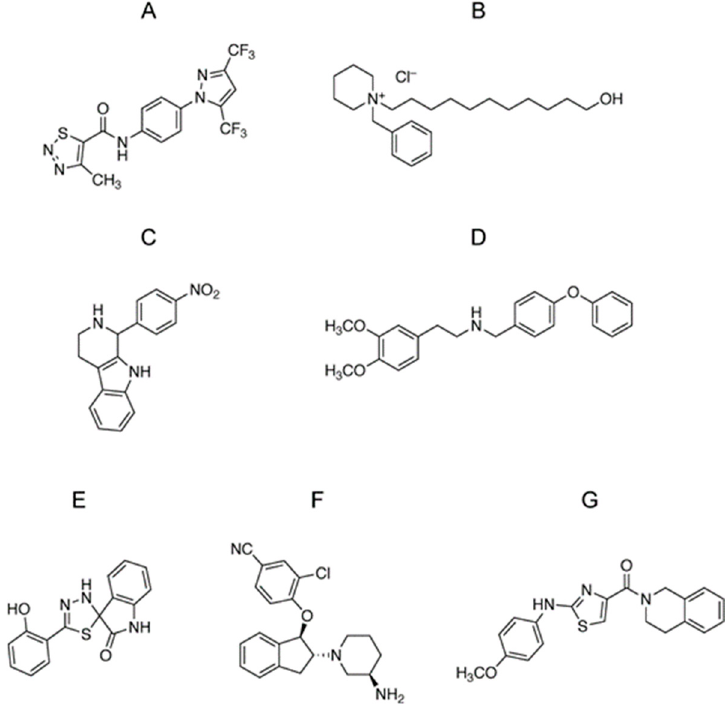
Figure 1. Chemical structures of TRPC3/C6 inhibitors identified in this study. Compound A, B, C, D, E, F and G are N-(4-(3,5-bis(trifluoromethyl)-1 H -pyrazol-1-yl)phenyl)-4-methyl-1,2,3-thiadiazole-5-carboxamide (Pyr2), 1-benzyl-1-(11-hydroxyundecyl)piperidin-1-ium chloride (1-BP), 1-(4-nitrophenyl)-2,3,4,9-tetrahydro-1 H -pyrido [3,4- b ]indole, 2-(3,4-dimethoxyphenyl)- N -(4-phenoxybenzyl)ethan-1-amine, 5 ′ -(2-hydroxyphenyl)-3 ′ H -spiro[indoline-3,2 ′ -[1,3,4]thiadiazol]-2-one, 4-(((1R,2R)-2-((R)-3-aminopiperidin-1-yl)-2,3-dihydro-1 H -inden-1-yl)oxy)-3-chlorobenzonitrile and (3,4-dihydroisoquinolin-2(1 H )-yl)(2-((4-methoxyphenyl)amino)thiazol-4-yl)methanone.